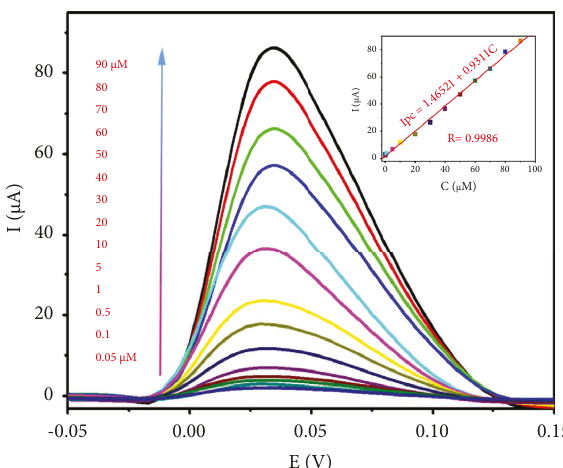
Figure 9: DPV curves of different concentrations of HQ (0.05–90 μ M) at Cu/rGO/GCE in 0.10M PBS (pH 6.5). The insert shows the relationship between peak current and concentration of HQ. Table 1: A comparison of the reported electrochemical sensors for hydroquinone.